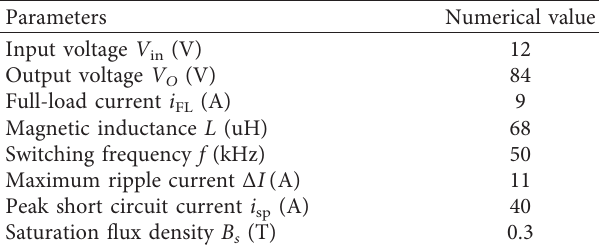
Table 2: Transformer design